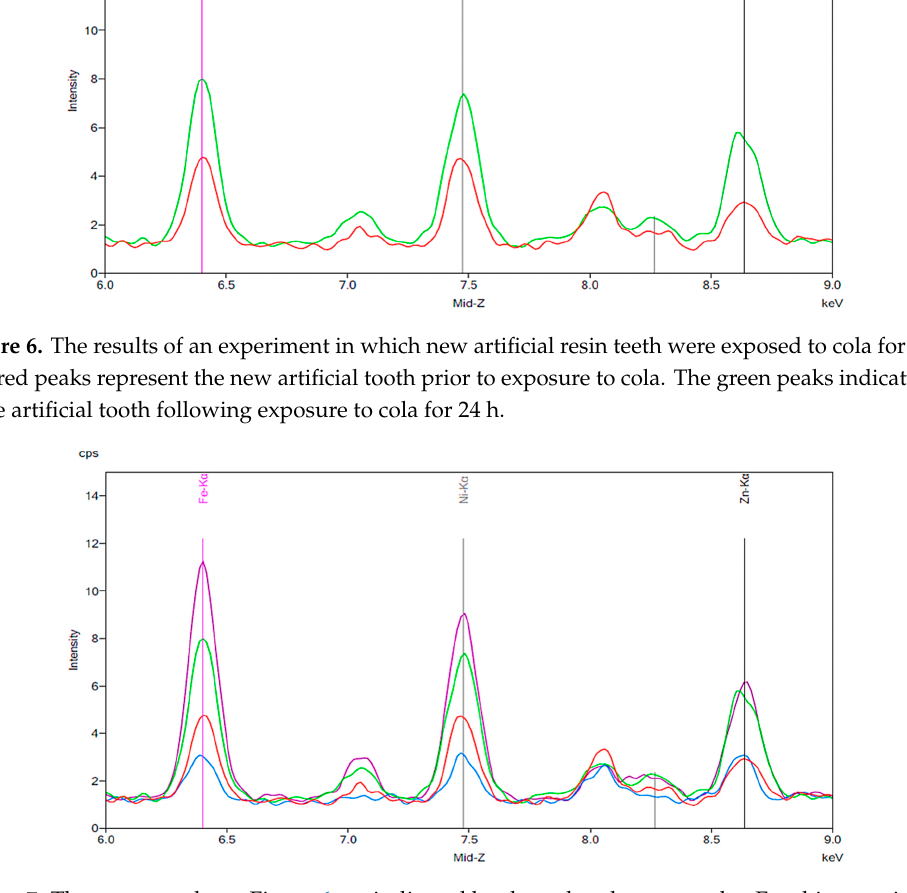
Figure 7. The same results as Figure 6 are indicated by the red and green peaks. For this experiment, the blue peaks represent a new artificial tooth after wear. The purple peaks correspond to the same artificial tooth following 24 h exposure to cola fluid.